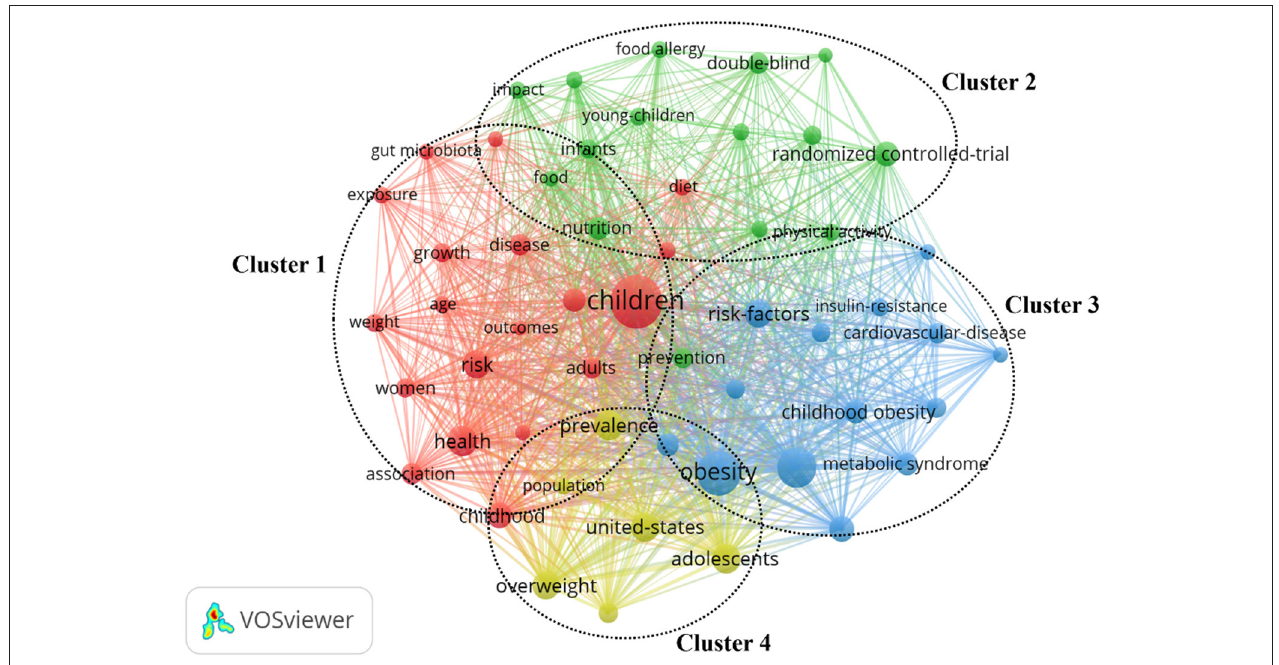
FIGURE 6 | The network map of keywords.